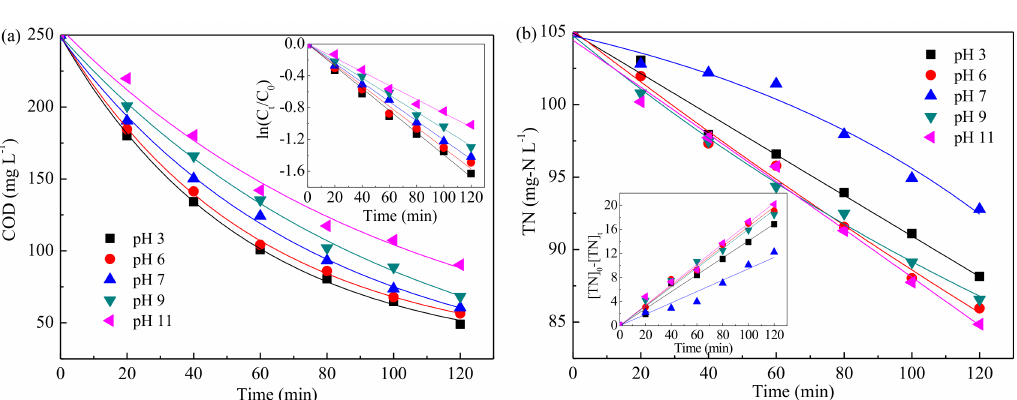
Figure 3. Effect of initial pH on COD ( a ) and TN ( b ) removal (no Cl − , 10.0 mA · cm − 2 , diluted H2SO4, and NaOH solutions were used for pH adjustments, and pH 6 was the natural pH of simulated wastewater).